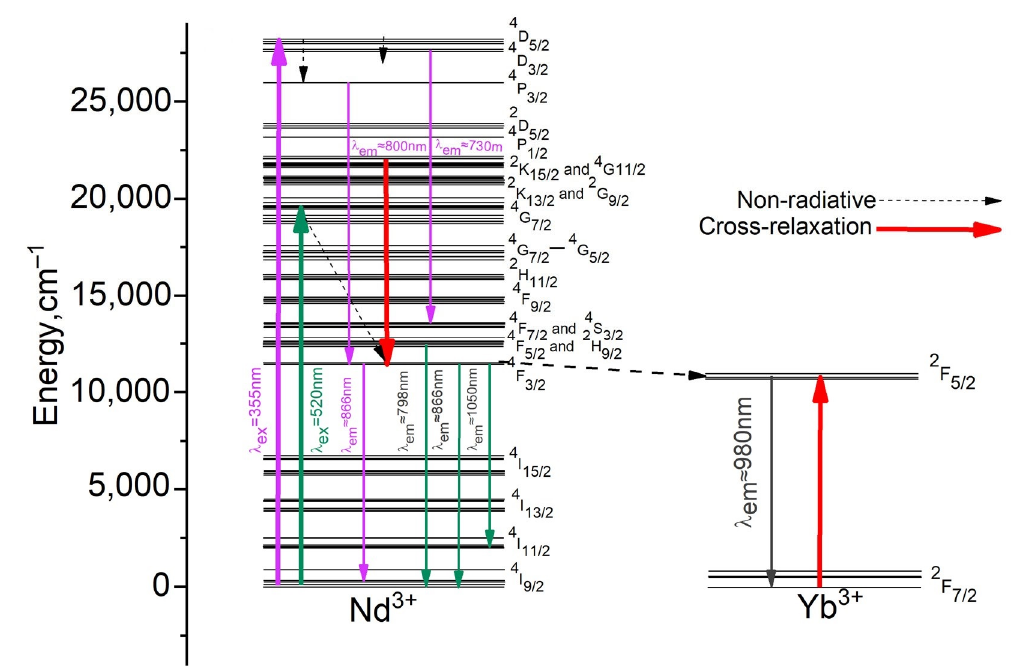
Figure 2. An energy level diagram of Nd 3+ , Yb 3+ system.